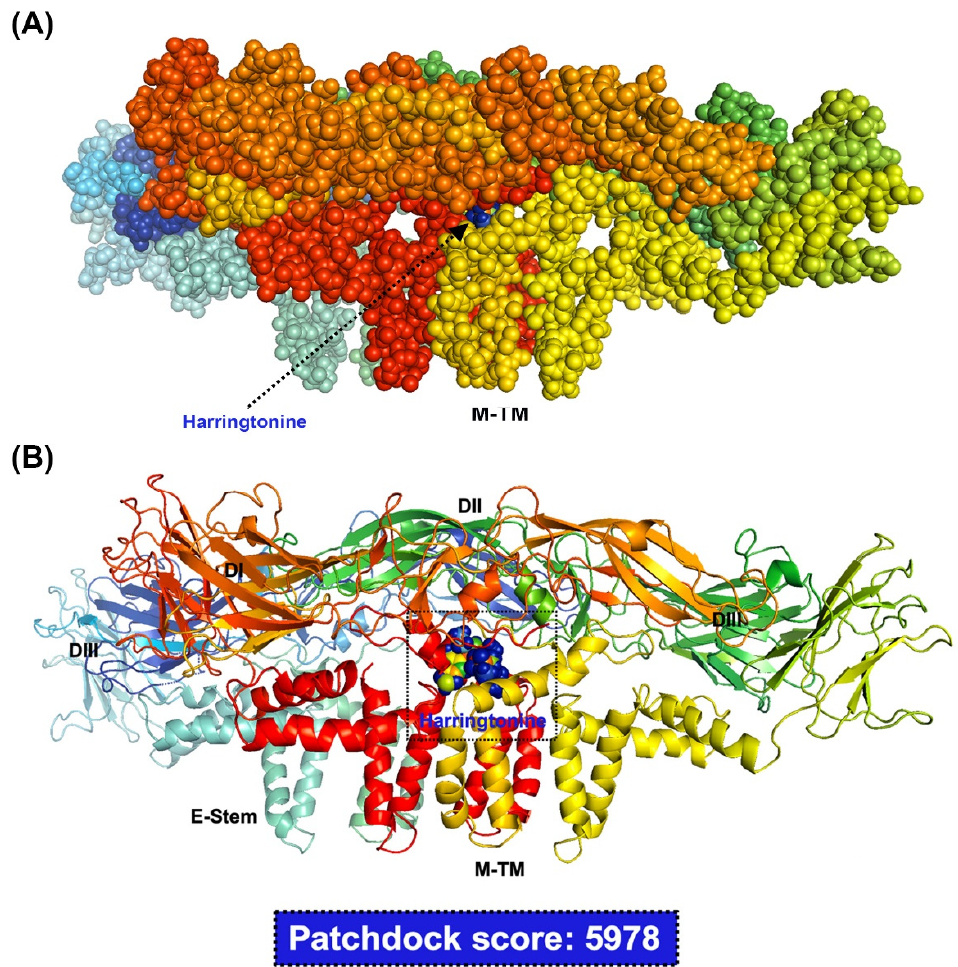
Figure 4. Molecular interactions of harringtonine with ZIKV envelope proteins using molecular docking analysis. Spheres rendered overview of ZIKV envelope proteins docked with harringtonine ( A ) and interaction of ZIKV envelope proteins with harringtonine (in ribbon) ( B ).